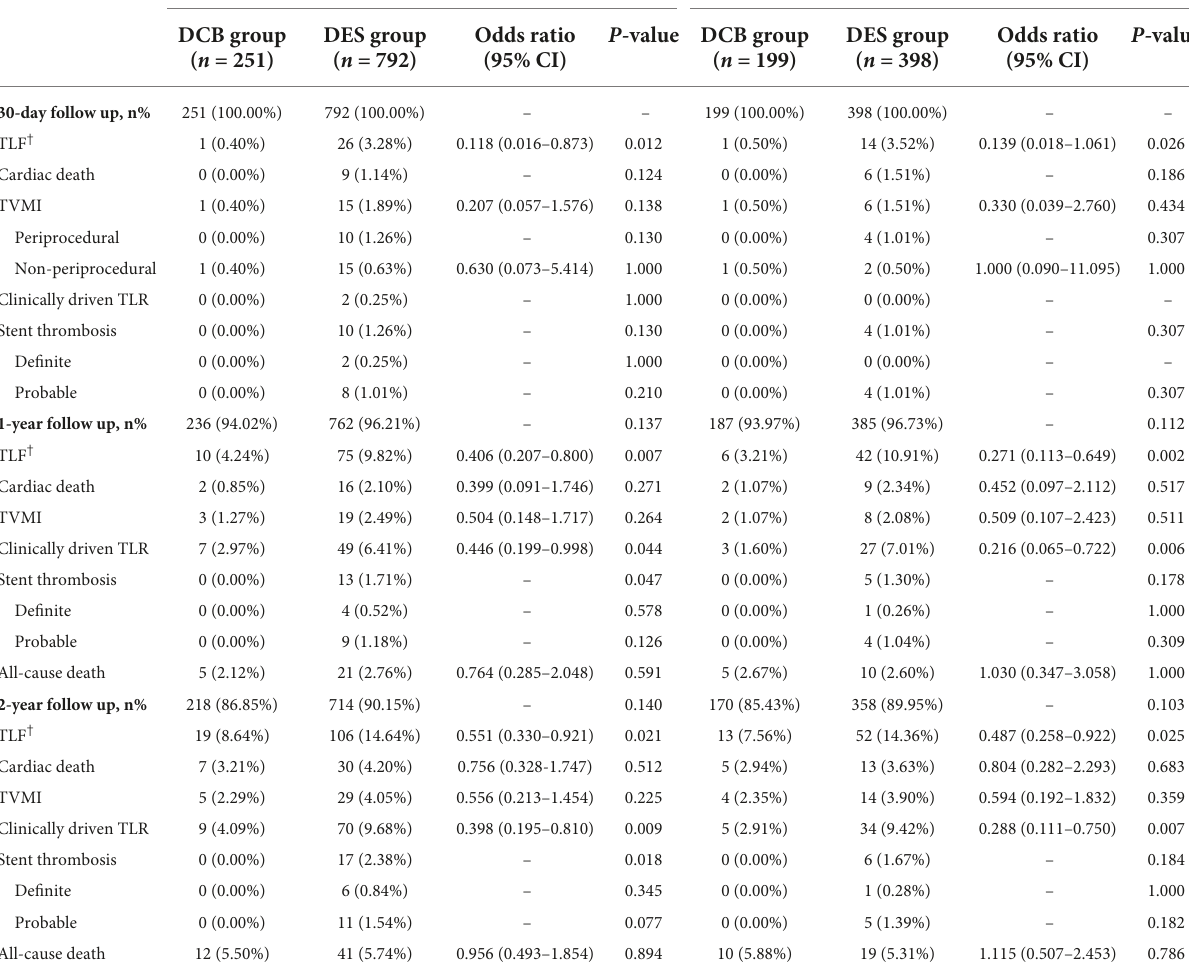
TABLE 4 Risk of clinical outcomes at 30-day and long-term